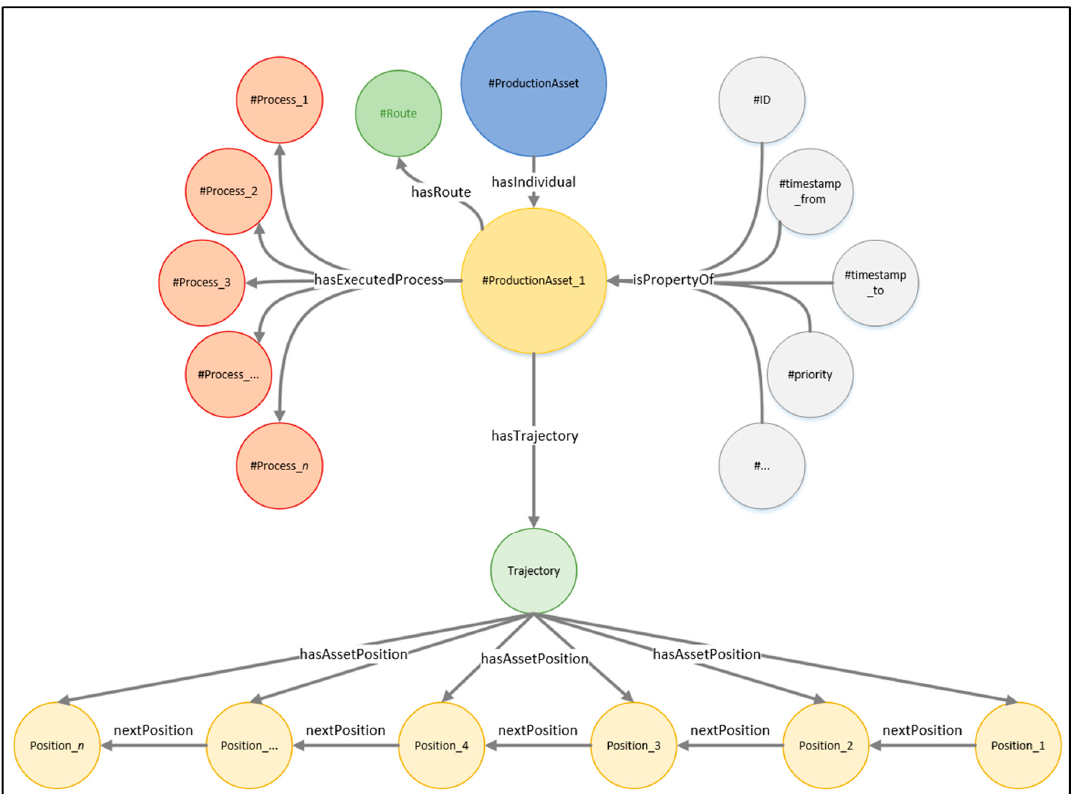
Figure 3. Visualization of the historical information of a production asset. Each circle represents an information artefact in the graph database that is connected to other information artefacts via relationships. A tagged arrow represents a relationship between two information artefacts. The blue circle denotes an abstract class, ProductionAsset, with its instance depicted by a yellow circle. Attached to the instance of the ProductionAsset are the executed processes, the trajectory with the sequence of positions, and a number of properties, which are represented as grey circles. The route is the collection of future production processes to be carried out [53].